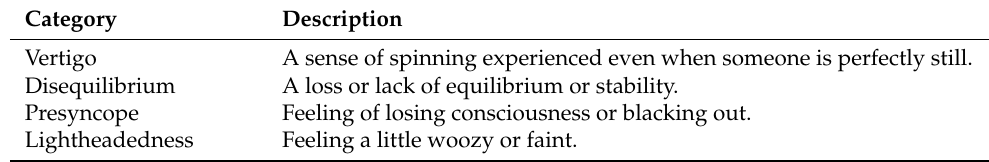
Table 1. Main categories of dizziness.